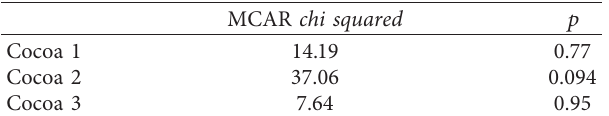
Table 2: Streak test, a value of p greater than 0.05 indicates that the losses are not